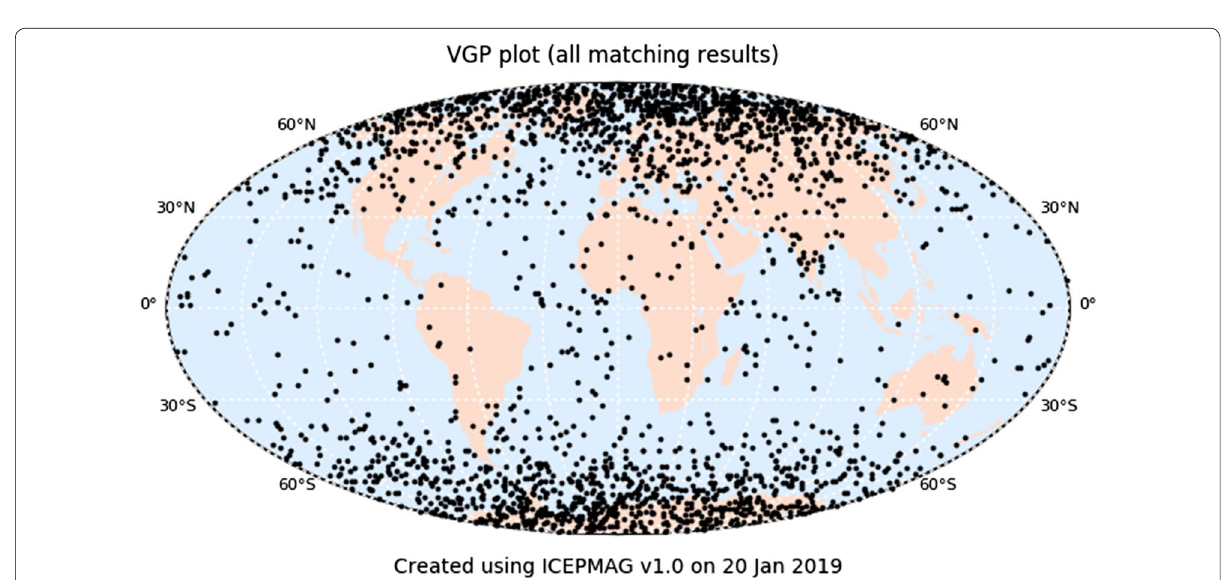
Fig. 5 Example of VGP plot. Screenshot of a VGP plot generated by an ICEPMAG query (all published VGP data from the